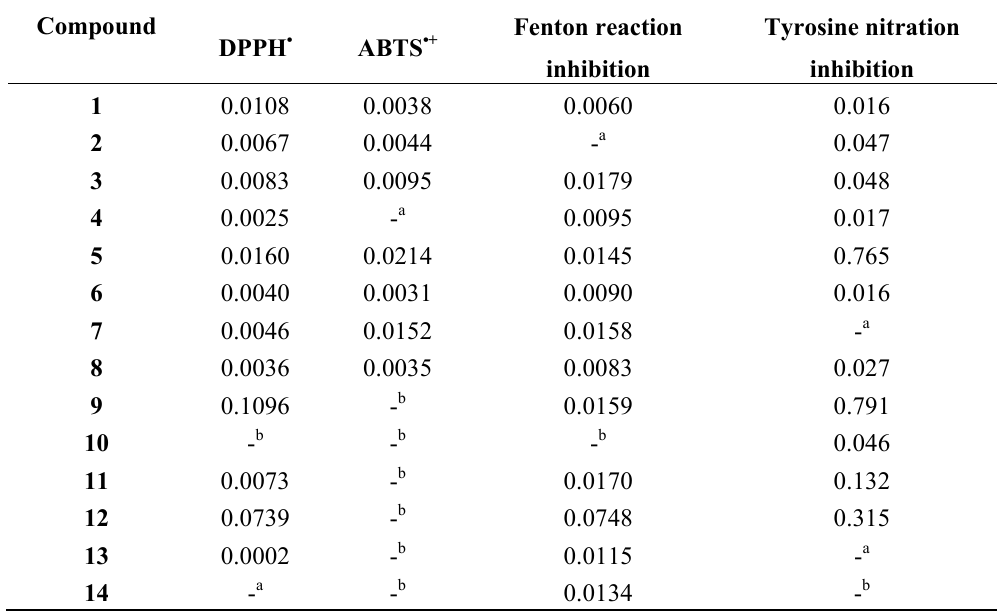
Table 1. Antioxidative activities of S. chinensis lignans 1 – 14 found using four experimental methods. Results are expressed as Trolox Equivalent Antioxidant Capacity (TEAC).